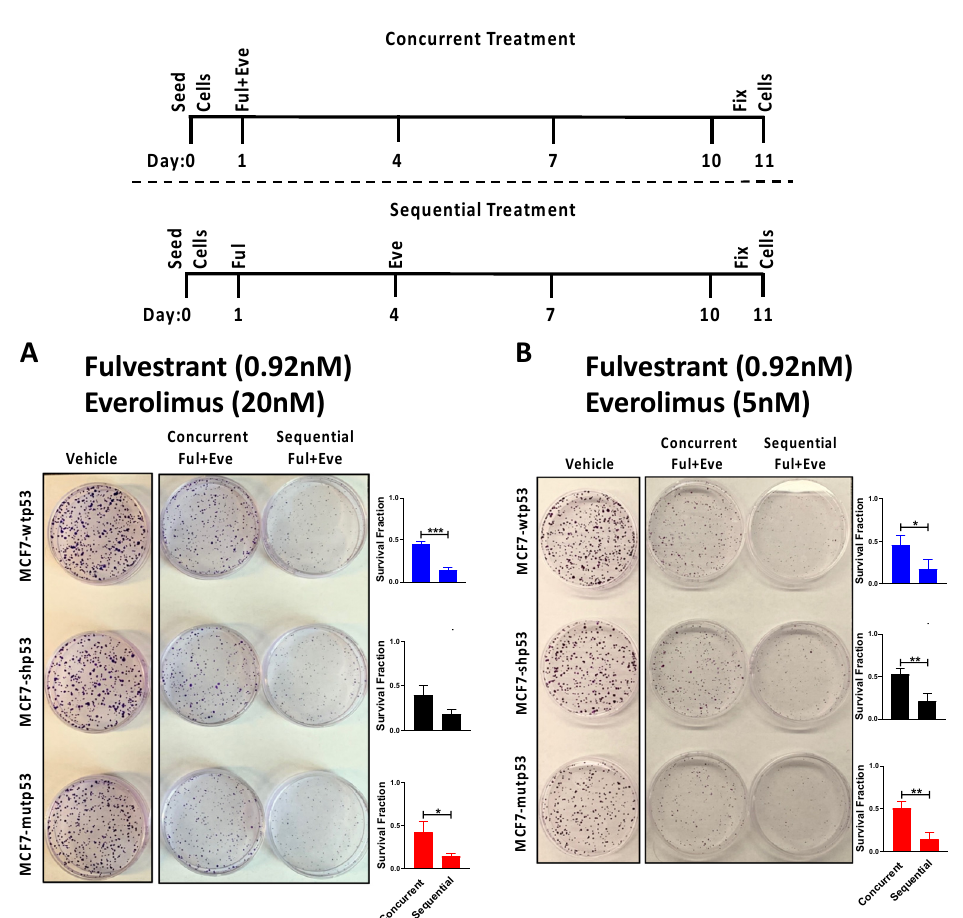
Figure 5. Sequential treatment of Fulvestrant and Everolimus is more efficacious than concurrent treatment in inhibiting clonogenic survival of LBC cells. Concurrent vs. sequential treatment of ( A ) Fulvestrant (0.92 nM) and Everolimus (20 nM) and ( B ) Fulvestrant (0.92 nM) and Everolimus (5 nM). Schematic of the dosing scheme is shown on the top. MCF7 isogenic cells differing in their p53 mutational status (MCF-wtp53, MCF7-shp53 and MCF7-mutp53), were seeded at low density on day 0. Cells were then treated with Fulvestrant (0.92 nM) and Everolimus as combination therapy 24 h post-seeding. For the combination treatment in the concurrent dosing scheme, cells were treated with both drugs at the same time on day 1. In the sequential dosing scheme Fulvestrant was treated 24 h post-seeding (day 1) and subsequently Everolimus was added 72 h (day 4) post Fulvestrant treatment in the combination treatment. Cells were then fixed 11 days post-seeding, and colonies were counted for further analysis. The effect of the dosing scheme on surviving colonies is pictorially and graphically represented. Values reflect mean ± standard deviation of three biological replicates. * p -value < 0.05, ** p -value < 0.01, *** p -value < 0.001 demonstrate statistical significance by